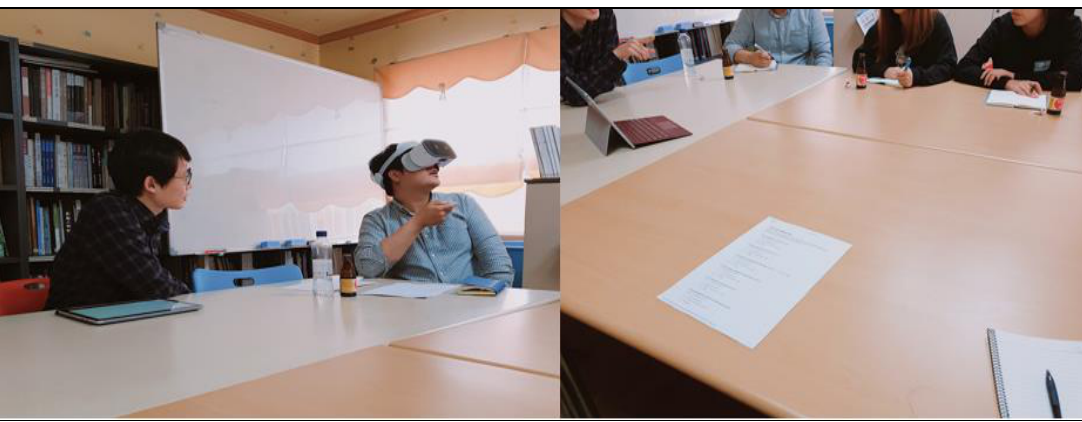
Table 2. Heuristic evaluation